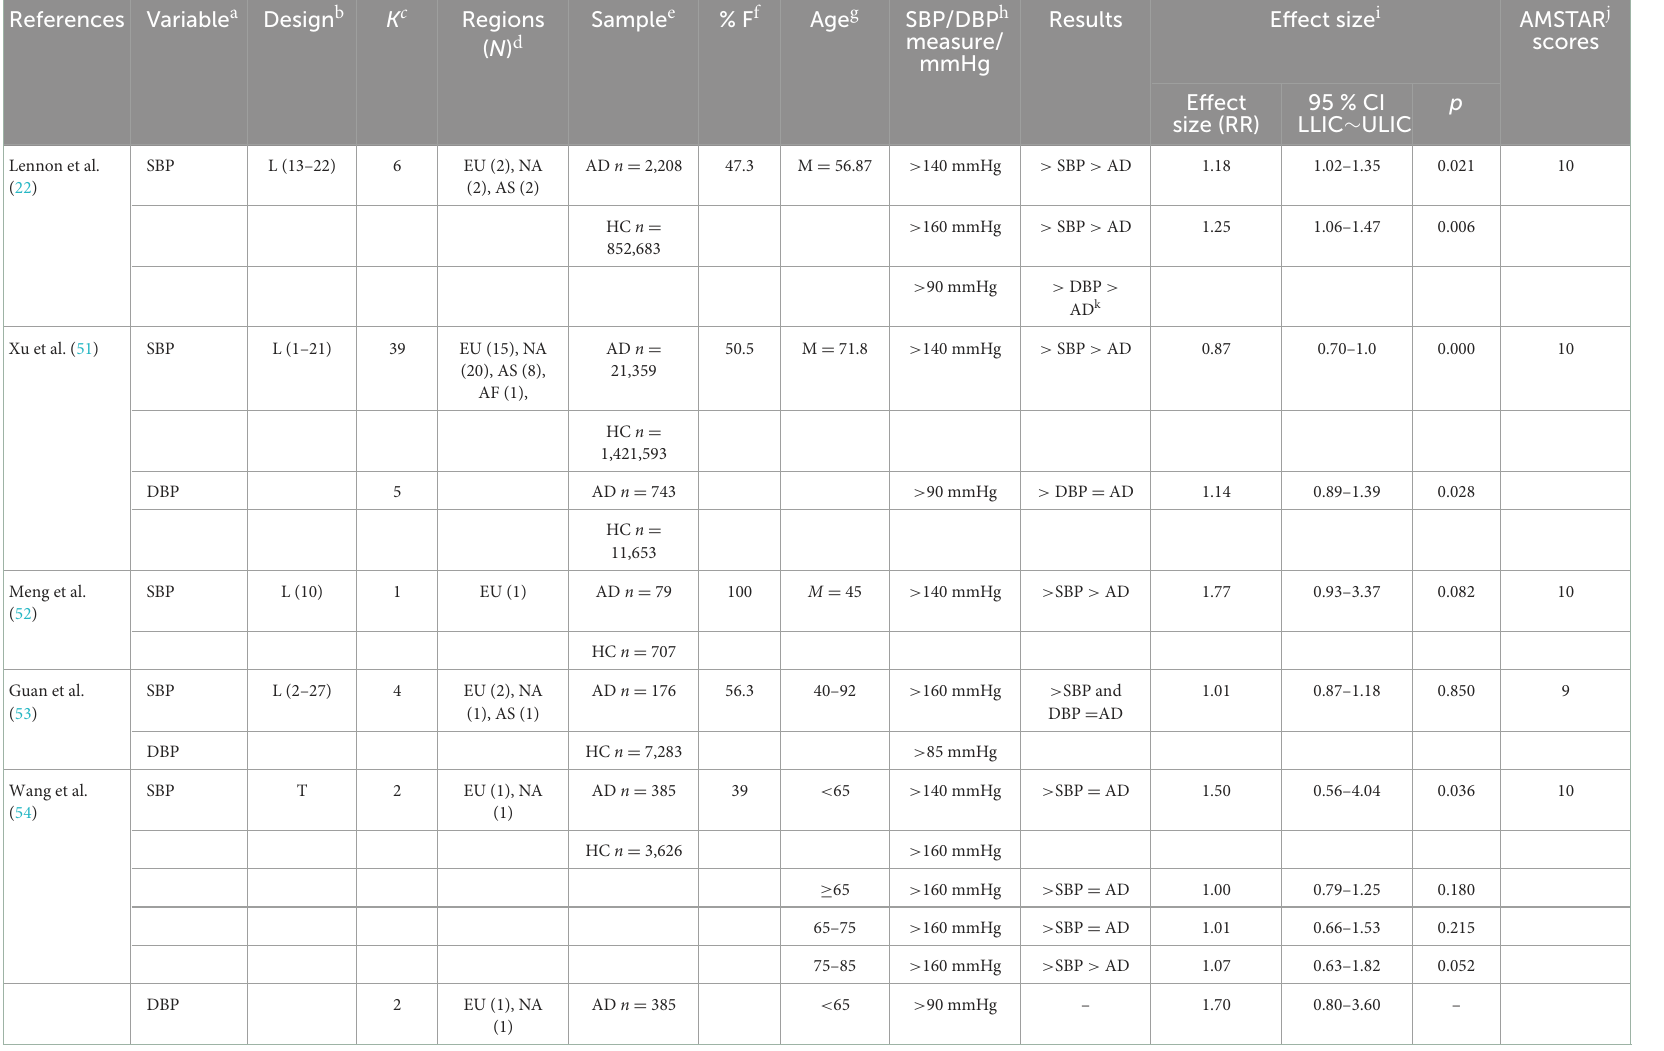
TABLE 1 Characteristics of the population of the AD and BP